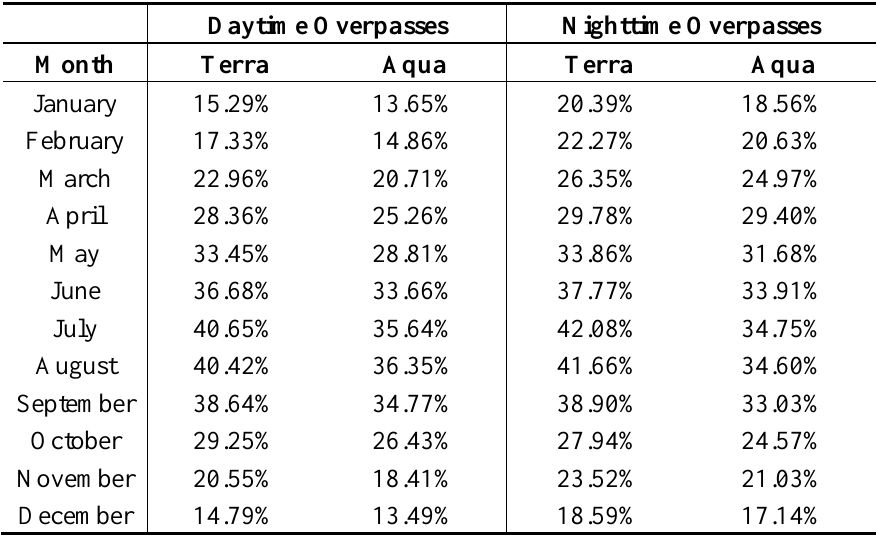
Table 3. Percent of valid non-ocean pixels per month in the original MODIS LST products for the European continent, averaged for the years 2000 to